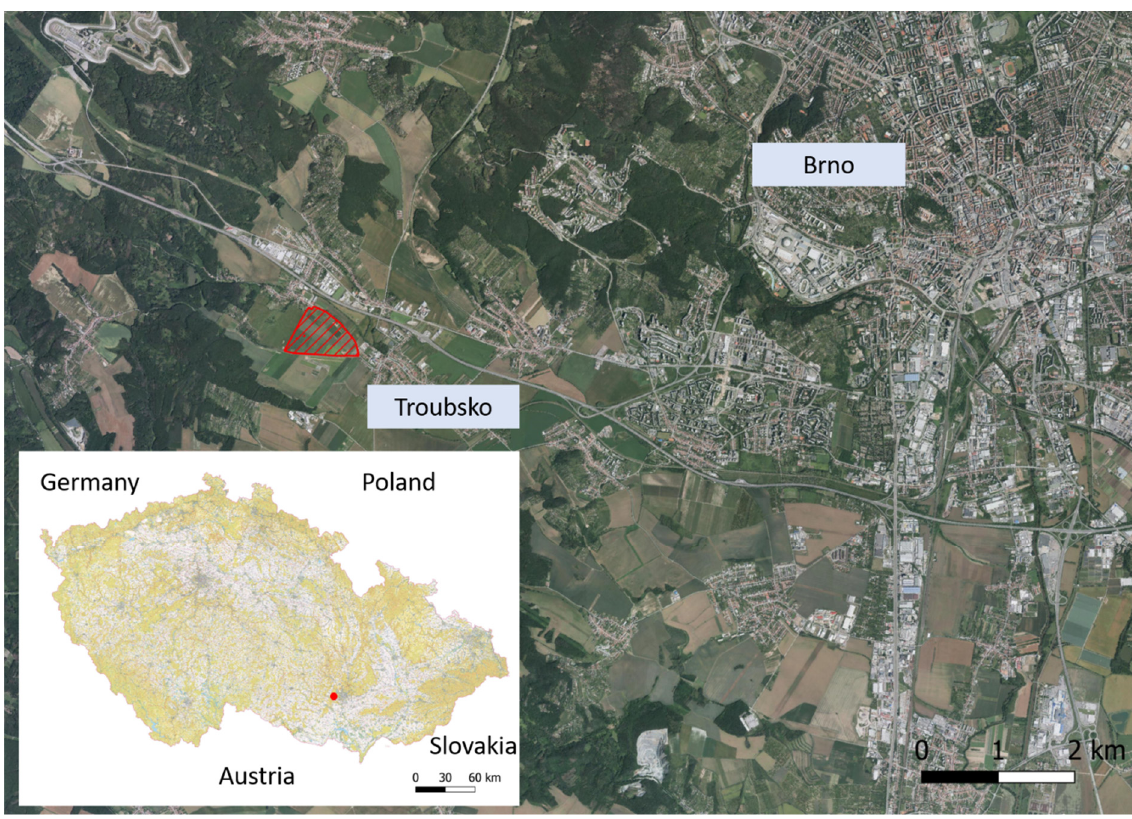
Figure 1. Location of the experimental site at the Troubsko, Czech Republic.